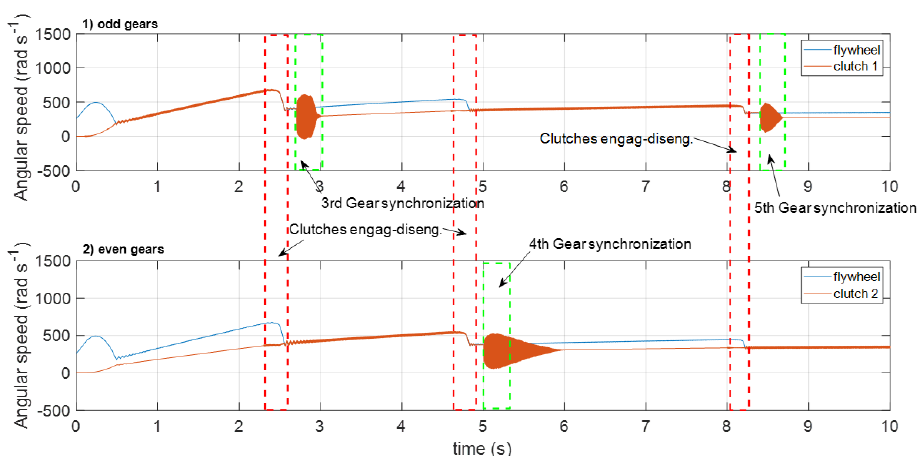
Figure 10. The DCT gear shifting transient: Cl 2 engaged with 2nd gear in running